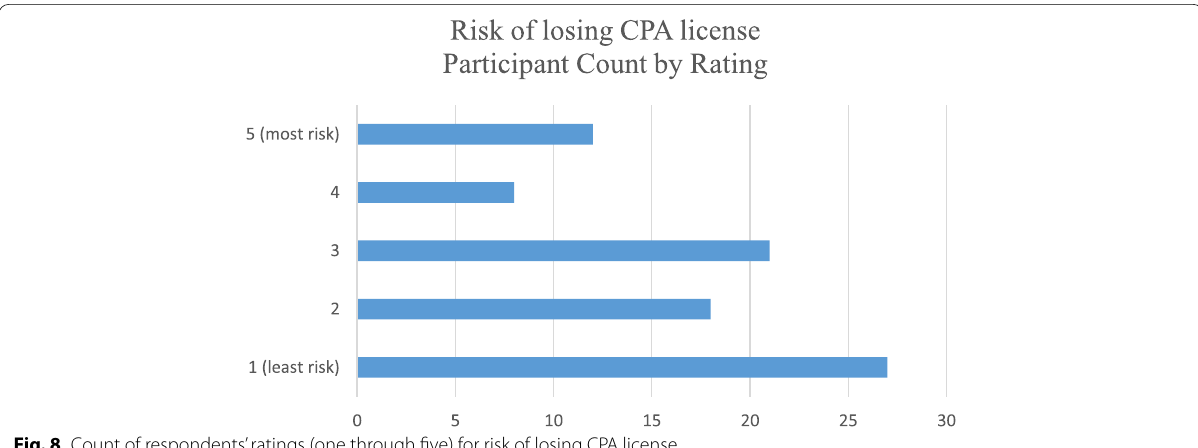
Fig. 8 Count of respondents’ ratings (one through five) for risk of losing CPA license